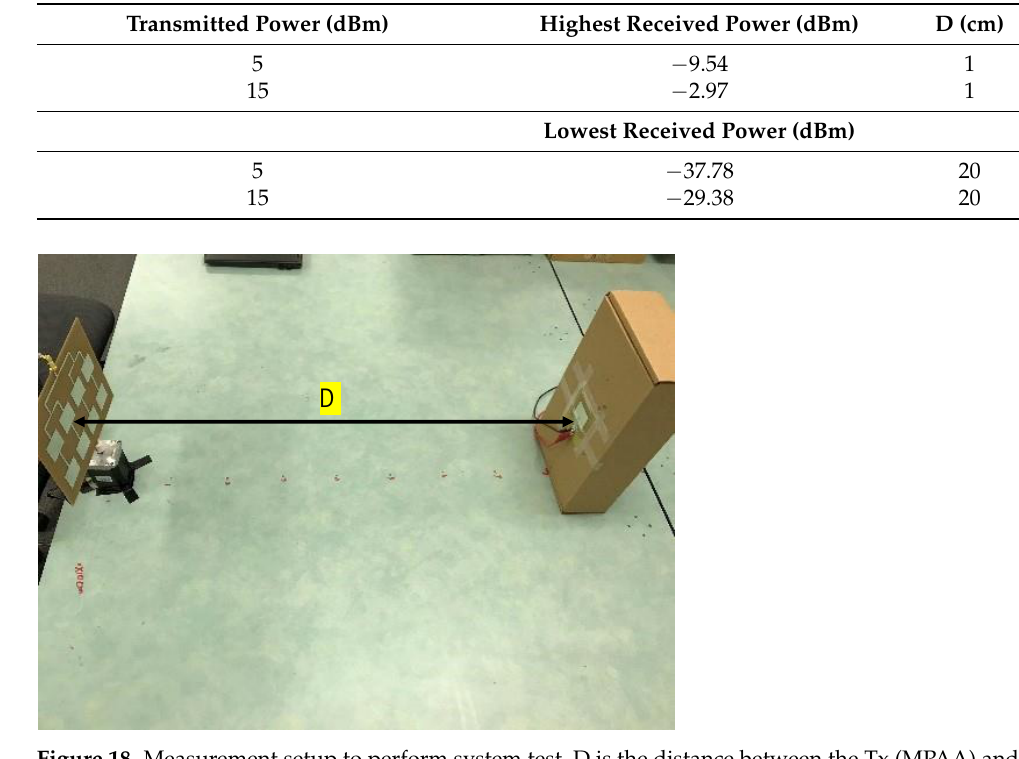
Figure 18. Measurement setup to perform system test, D is the distance between the Tx (MPAA) and the Rx (MPA).